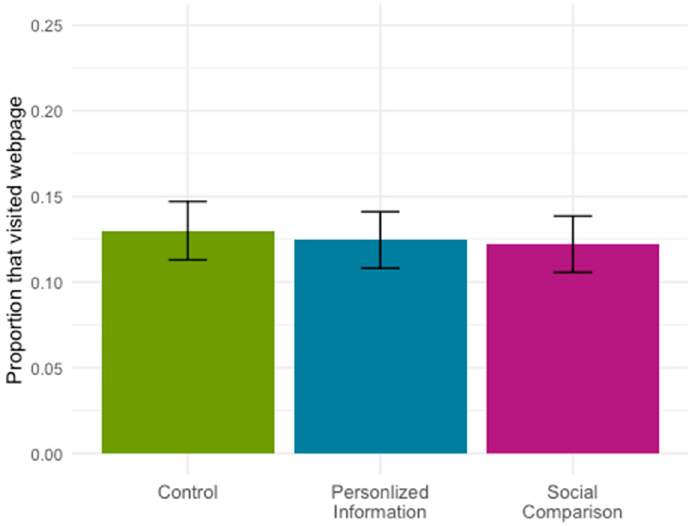
Figure 2. Webpage visits by treatment version: community risk (Control; n = 1492), community and parcel risk (Personalized Information; n = 1541), and community, parcel and neighbor risk (Social Comparison; n = 1531). Error bars show 95% confidence interval.